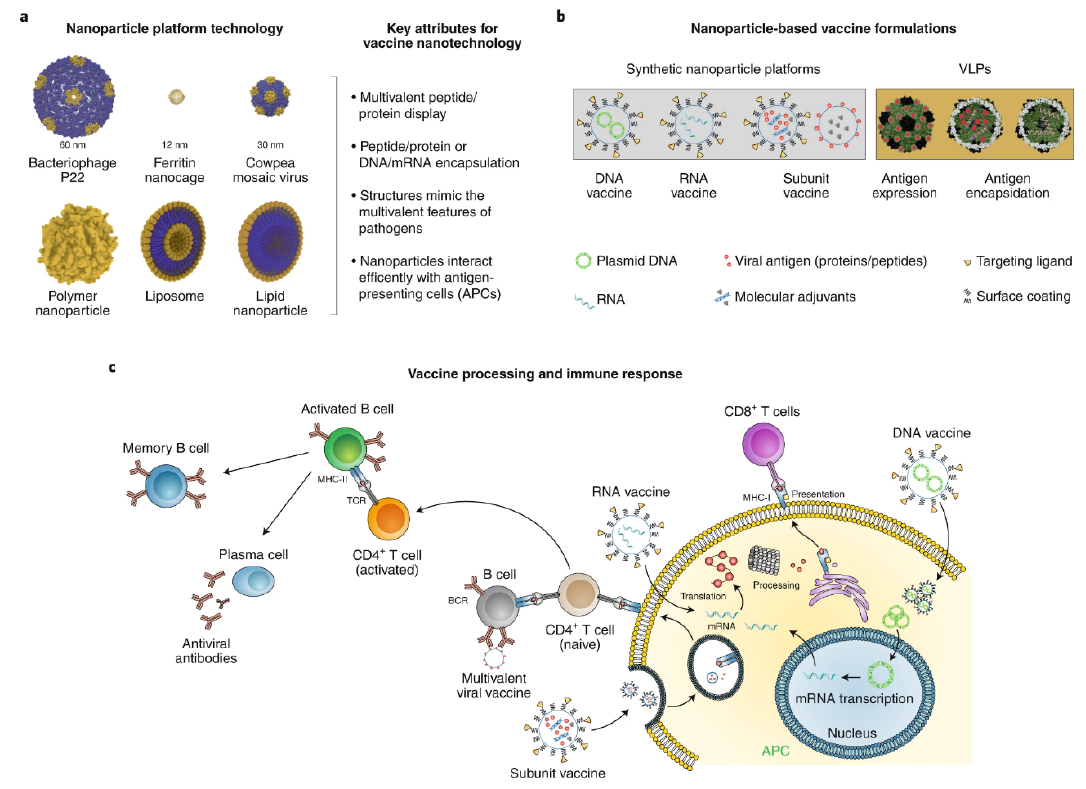
Figure 4. Nanoparticle platform vaccine technologies [145] .